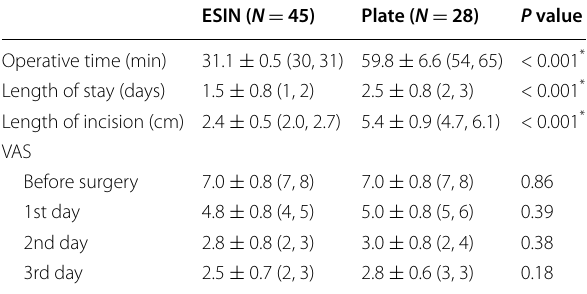
Values of continuous variables are described as mean VAS visual analogue scale, ESIN elastic stable intramedullary nail * P 0.05 ≤ Table 3 Postoperative and follow-up outcomes